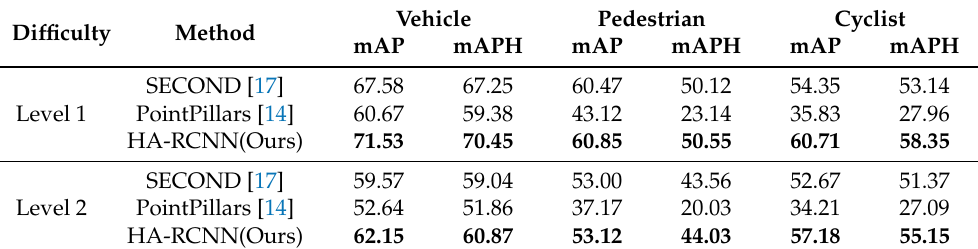
Table 3. State-of-the-art comparisons for 3D detection on the Waymo test set showing the mAP and mAPH for both Level 1 and Level 2